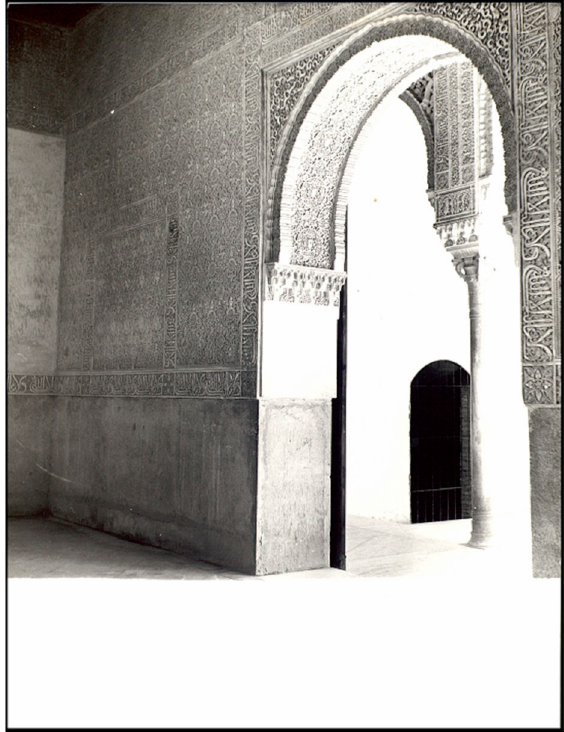
Figure 25. South and east wall of the Cuarto Dorado prior to the replacement of ceramic dadoes in September 1966. © Archivo del Patronato de la Alhambra y Generalife, Photograph Collection,